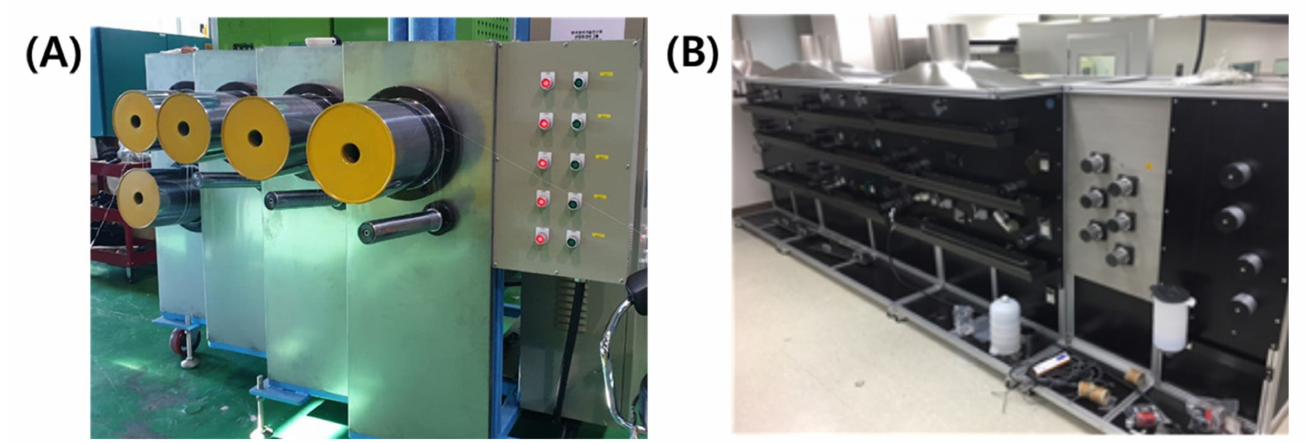
Figure 3. Drawing equipment ( A ) dry drawing, and ( B ) wet